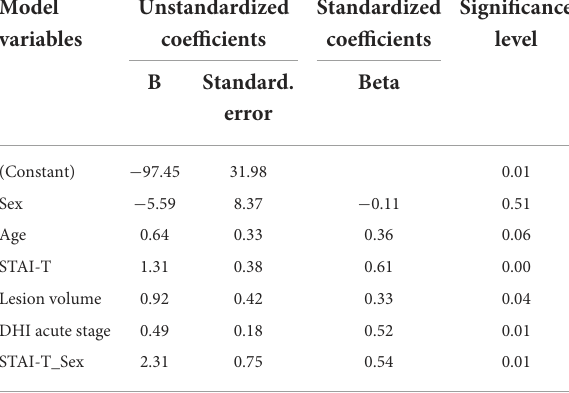
TABLE 3 Multiple linear regression model with EQ-VAS at follow-up as dependent variable and outcome parameter. Model Unstandardized Standardized